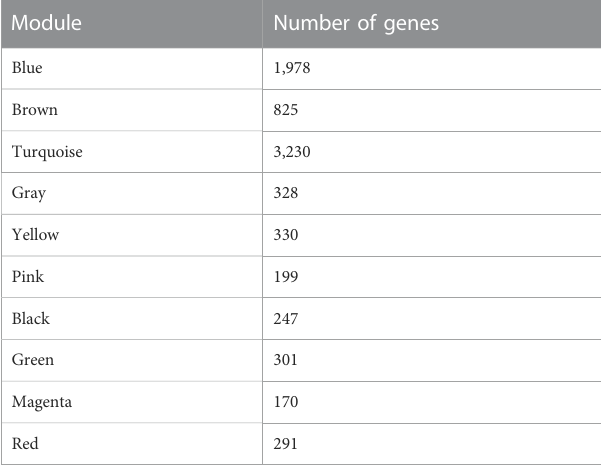
TABLE 5 Number of genes in each module identi fi ed using WGCNA.